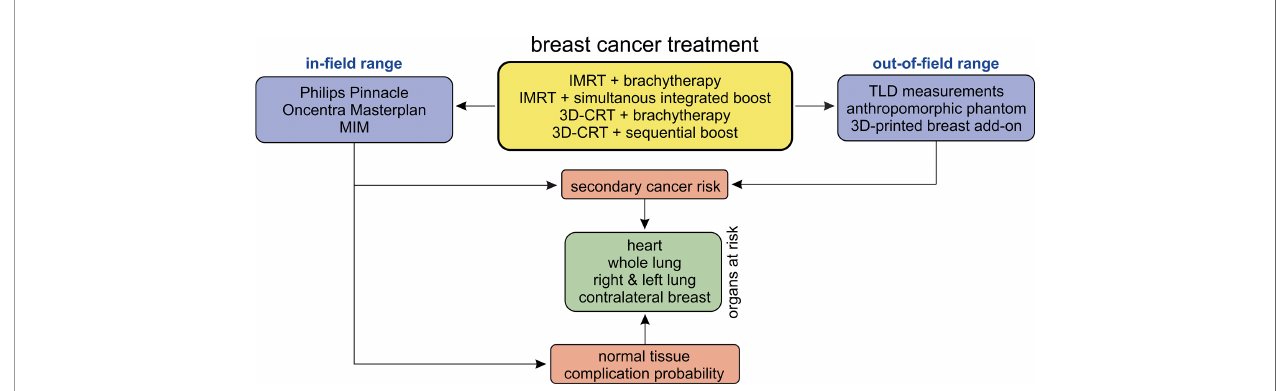
FIGURE 1 | Schematic of the study